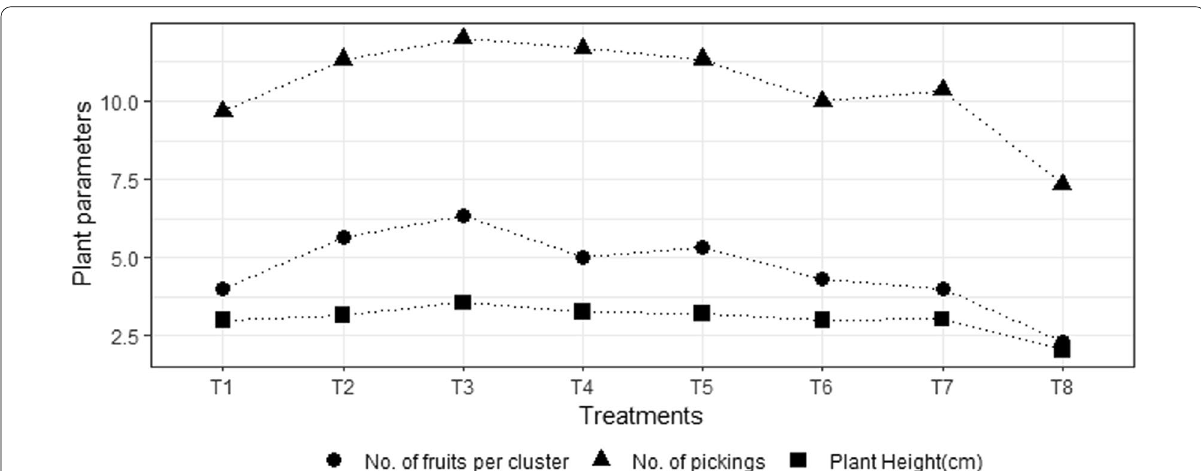
Fig. 2 Pooled analysis of various treatments and their influence on plant parameters (Kharif 2017–2018 and 2018–2019). As compared to control T 8, all the treatments have significant impact ( p < 0.05) on the plant parameters (plant height, number of fruits per cluster and number of pickings). This figure shows that as compare to other treatments, plant parameters are comparatively higher ( p < 0.05) with the treatment T 3 and provided a maximum yield followed by the treatments T 2, T 5 and T 6